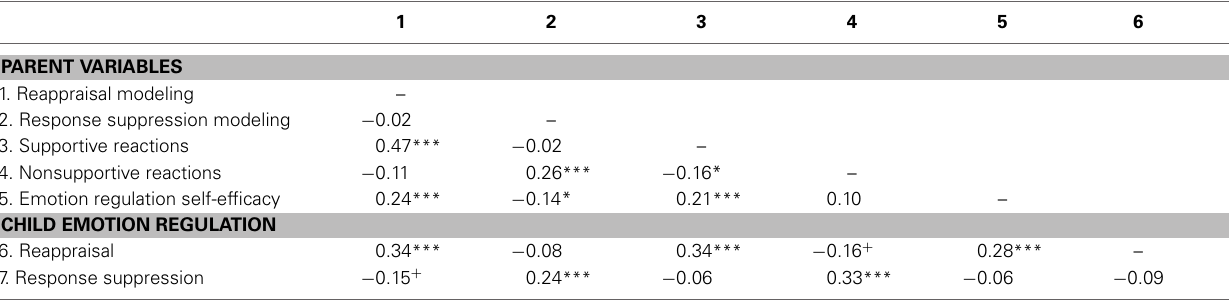
Table 3 | Bivariate correlations of all study